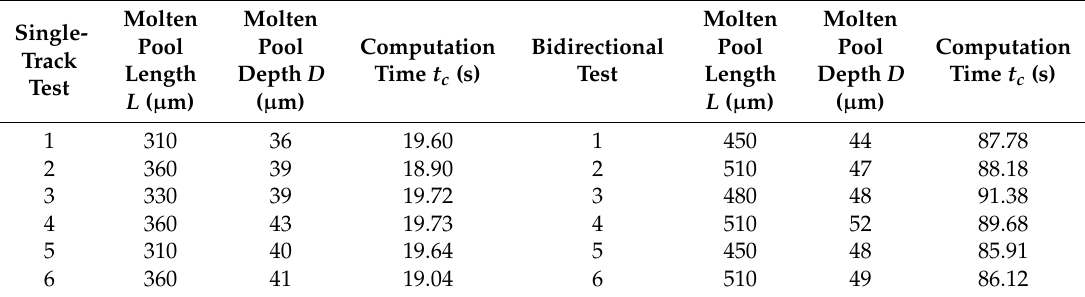
Table 4. Predicted molten pool dimensions for single-track scans and bidirectional scan under steady-